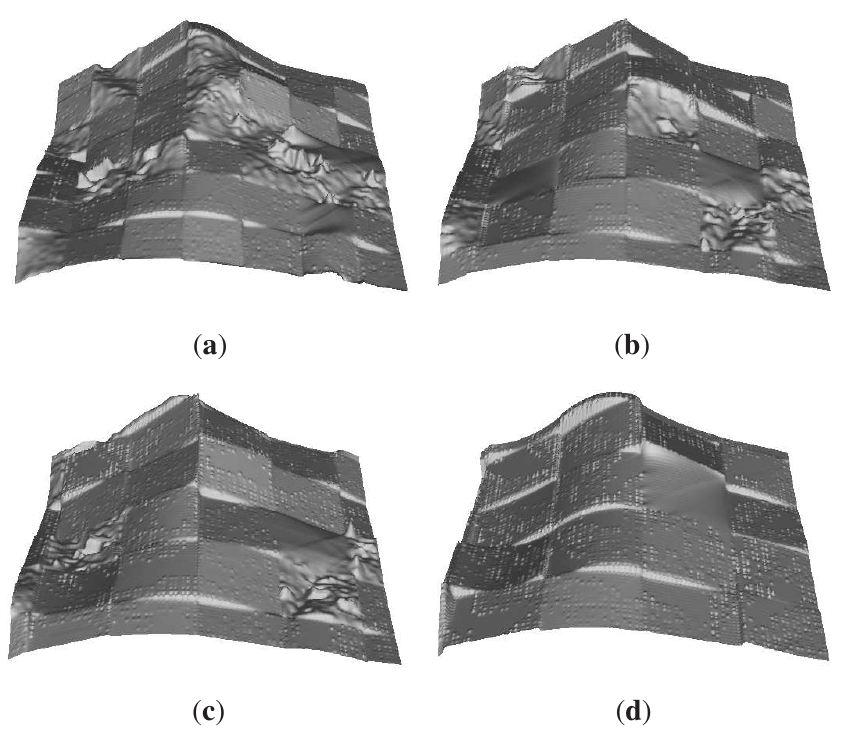
Figure 1. Example from Site 1 illustrating repeated sampling of elevation values at DTM locations by repeating DTM interpolation using increasing patch widths ranging from 50 to 80 m at increments of 10 m. (a) Patch width = 50; (b) Patch width = 60; (c) Patch width = 70; (d) Patch width =